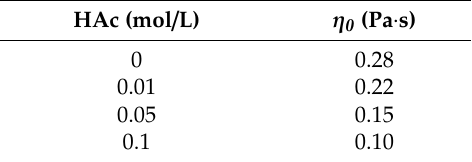
Figure 5. Steady flow curves of 10 mg/mL GPAM2 solutions ( a ) with different HAc concentration and ( b ) with and without a thermal treatment (holding at 60 °C for 15 min). All tests were conducted at 10 °C. Table 1. η 0 of 10 mg / mL chitosan-grafted-polyacrylamide 2 (GPAM2) solutions with di ff erent HAc concentration at 10 ◦